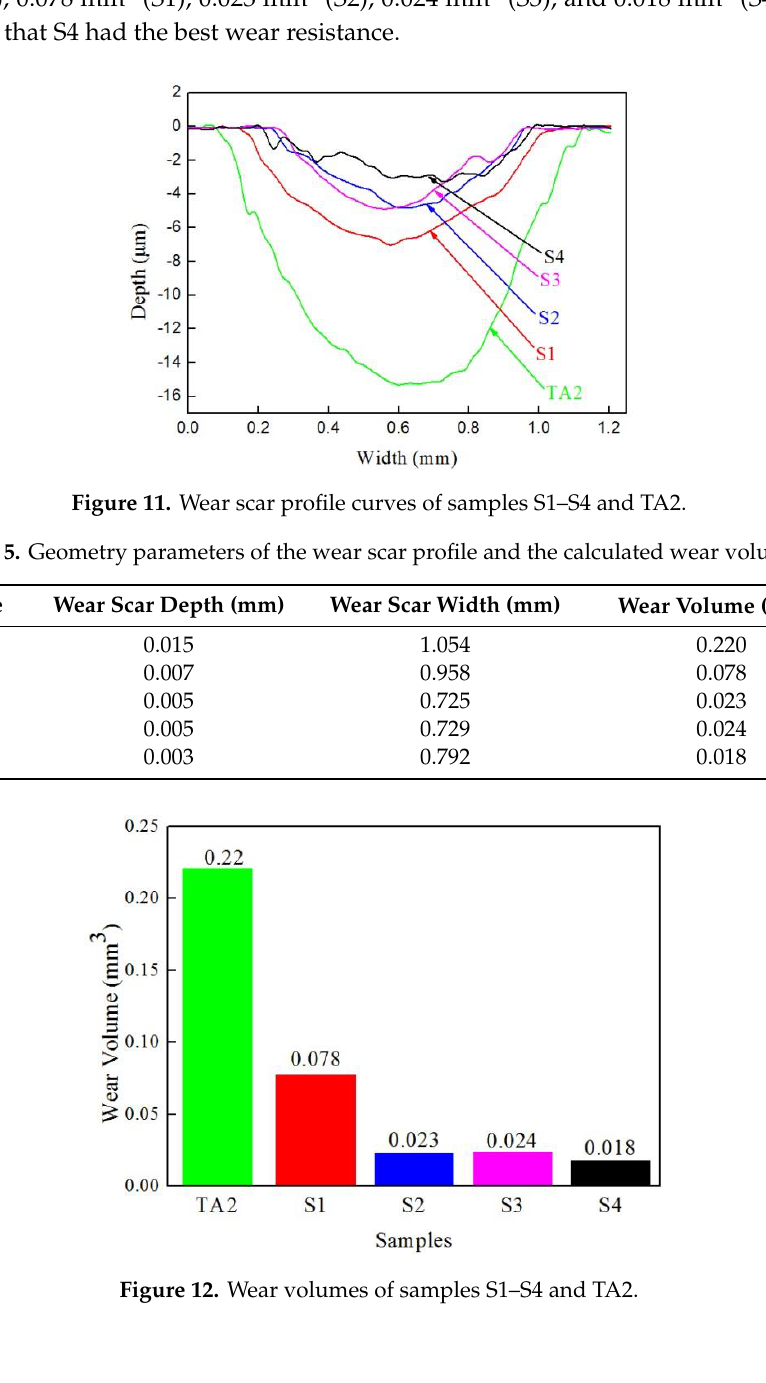
Figure 10. Friction coefficient of samples S1 – S4 and TA2.